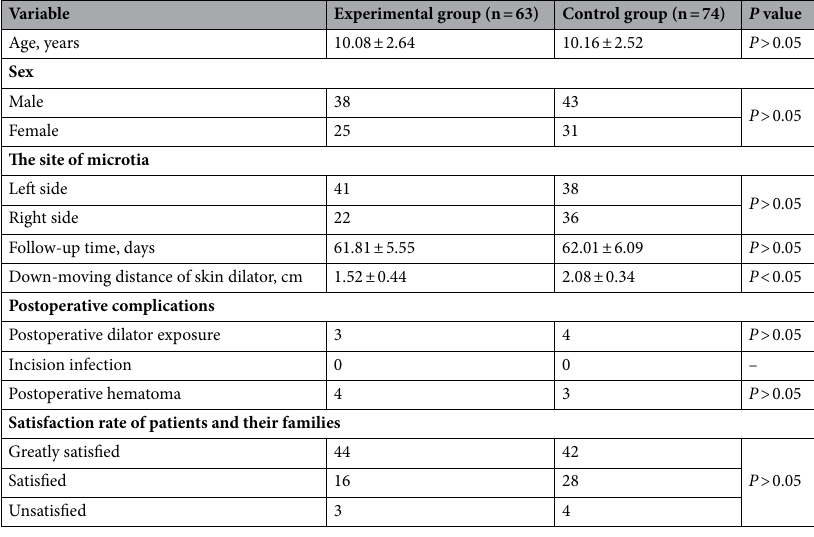
Table 1. Data summary